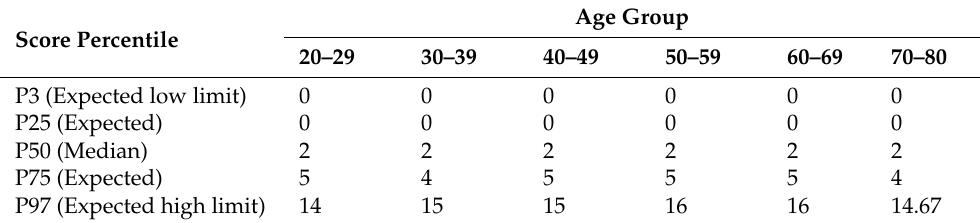
Table 4. PHQ-9 percentile score divided by age group.